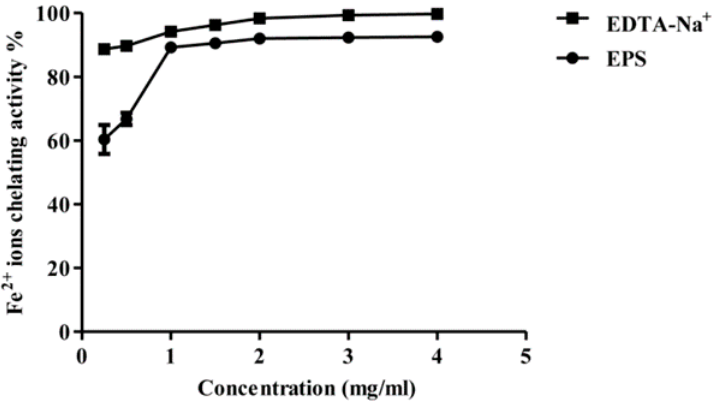
Figure 9. Ferrous ion chelating activity of different concentrations of MOE6-EPS (0.25, 0.5, 1, 1.5, 2, 3, 4 mg/mL) from Streptomyces sp. MOE6 compared to that of EDTA-Na + (0.25, 0.5, 1, 1.5, 2, 3, 4 mg/mL) as a positive control. Values are means ± SD ( n = 3). 100% ( w/v ) Fe 2+ was 111.6 μ g/mL. The absence of error bars indicates that the errors were smaller than the symbols.